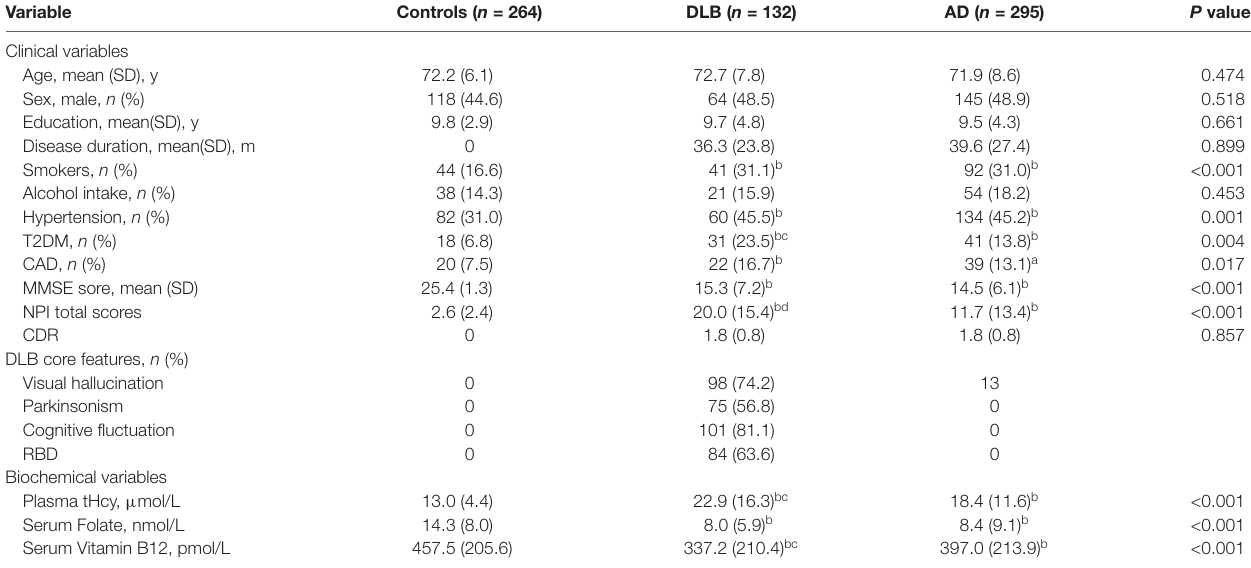
TABLE 1 | Characteristics of Control, DLB, and AD